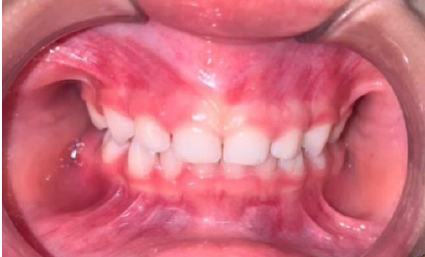
Figure 8. Stabilized occlusion after eruption of primary first molars.